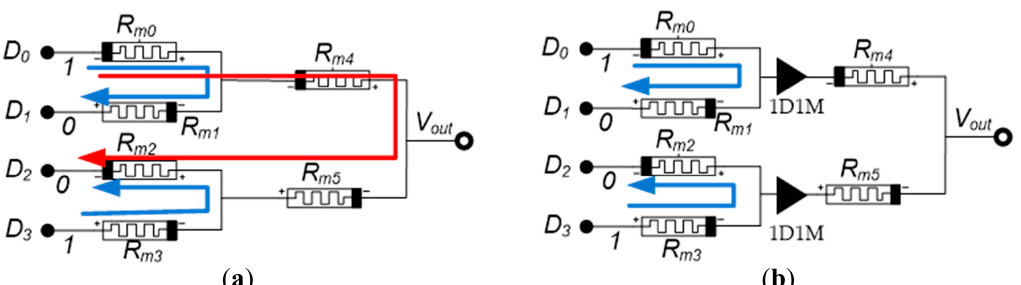
Figure 19. The sneak path issue and its solution in a memristor DAC. ( a ) A memristor DAC with a sneak path problem; ( b ) A memristor DAC using the sneak path solution (1D1M).